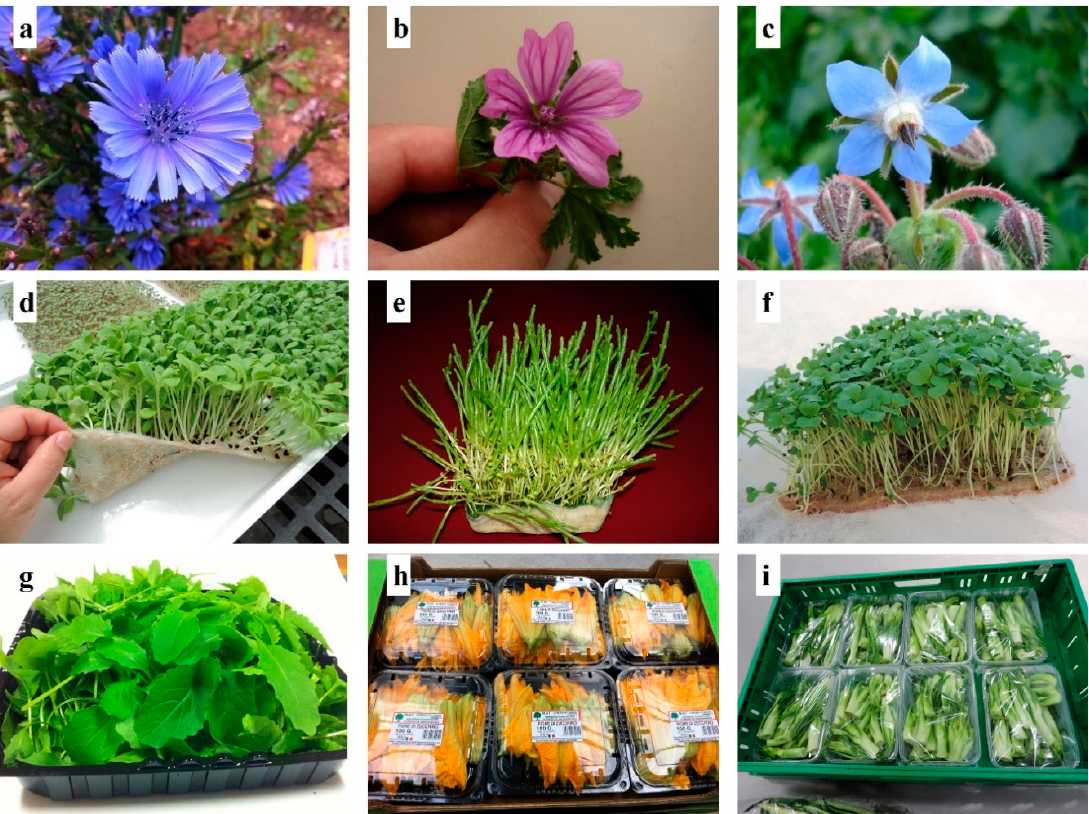
Figure 3. Example of typical Mediterranean wild edible plants and vegetable local landraces suitable to produce edible flowers of ( a ) Cichorium intybus L., ( b ) Malva sylvestris L., ( c ) Borago officinalis L.; microgreens of ( d ) Borago officinalis L., ( e ) Salicornia patula Duval-Jouve, ( f ) Brassica rapa L. Broccoletto group; ( g ) baby-leaf of Brassica rapa L. selection “Sessantina”; ( h ) fresh-cut zucchini squash flowers, and ( i ) fresh-cut stems of Cichorium intybus L. selection ‘Molfettese’. Photo credits: Francesco Di Gioia.